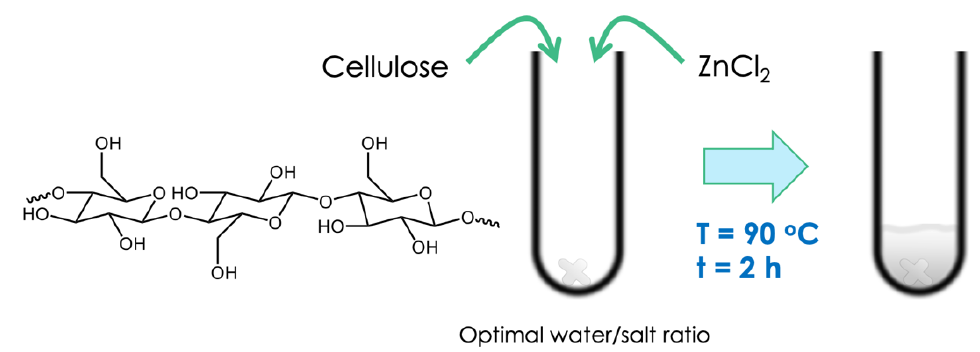
Figure 14. Example of cellulose hydrolysis using molten salt